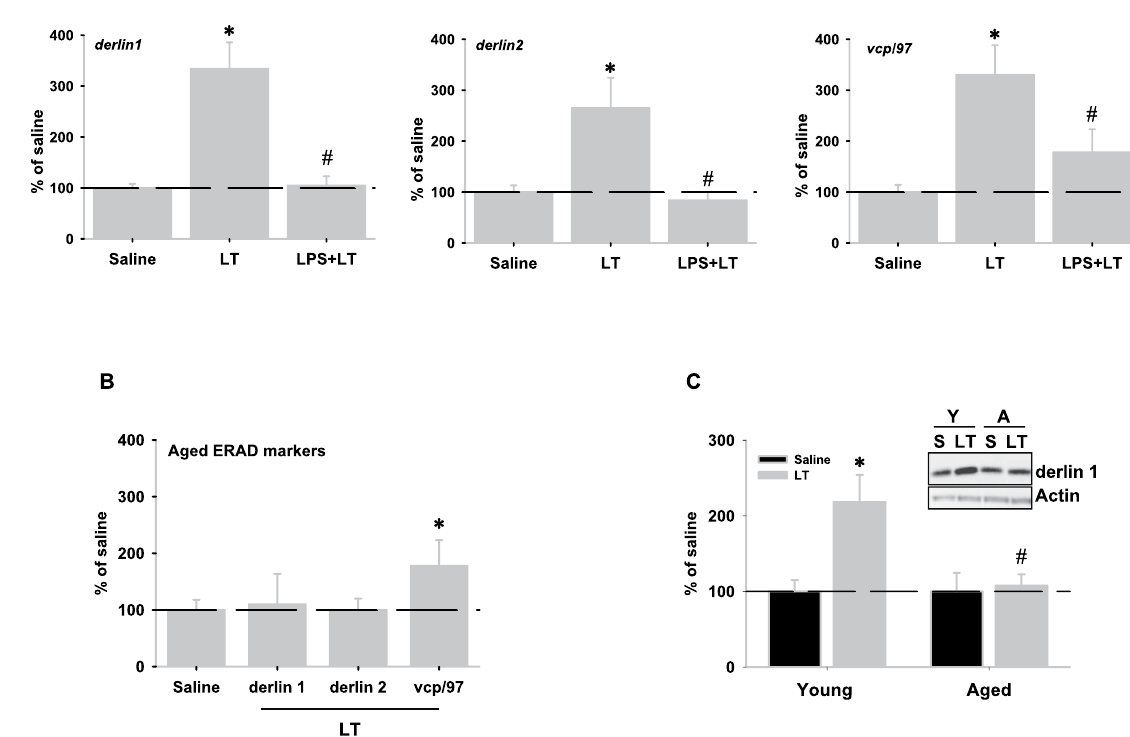
Figure 7. LPS injection attenuates lactacystin-induced up-regulation of ERAD markers. ( A ) mRNA expression of several ERAD markers was analyzed by RT-real time PCR 24 hours after saline (SAL), saline + lactacystin (LT) or LT-injection 24 hours after LPS-injection (LPS + LT). LT-injection induced a significant increase in the mRNA expression of the three ERAD markers, derlin1 , derlin2 and vcp/97 , compared to SAL animals. This mRNA up-regulation was abolished ( derlin1 and derlin2 ) or attenuated ( vcp/97 ) in animals that previously received LPS-injection (LPS + LT). ( B ) mRNA expression of ERAD genes in aged rat hippocampus 24 hours following LT-injection. Note that LT-injection just up-regulated mRNA expression of vcp/97 in aged animals, while the rest remained similar to aged saline-injected rats. ( C ) Representative western blot and quantification by optical density corresponding to the protein Derlin1 in both young and aged rat hippocampus 24 hours after LT-injection. Note the absence of induction in aged rats. Data are presented as mean ± SD (n = 4 young, and n = 3 aged rats) of percentage of variation relative to controls. * p < 0.05, significant differences compared with control (saline-injected) animals. # p < 0.05, significant differences compared with young LT-injected